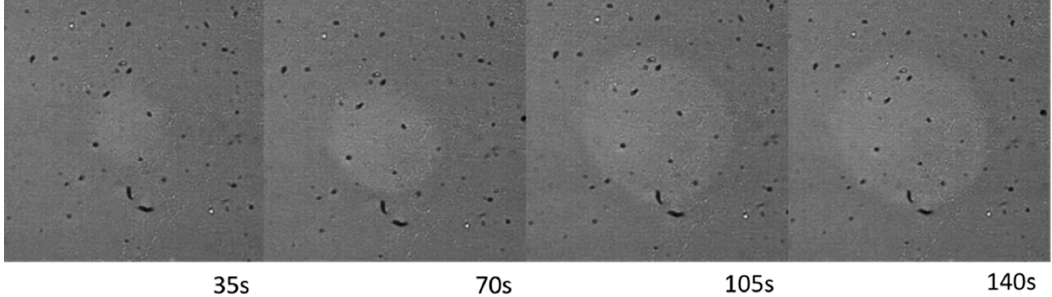
Figure 2. Heating schedule for dots created with a ‘ring’ procedure. The glass is illuminated with a circular beam of uniform intensity during the nucleation stage, designated in the figure, followed power density throughout crystallization.